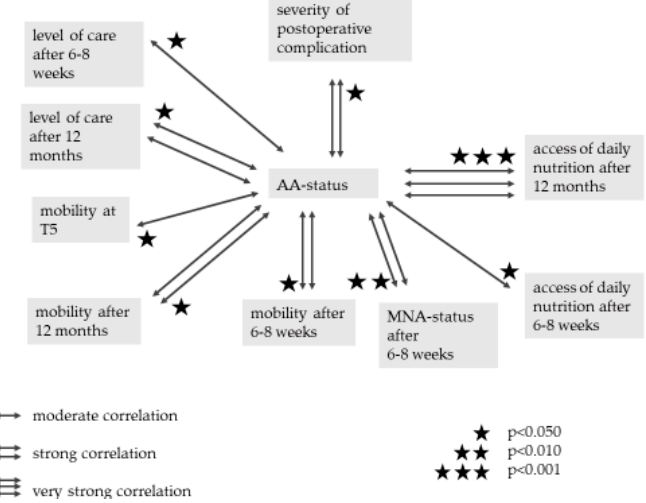
Figure 7. Impact of AA status at T4 (day of discharge from hospital) on clinical parameters.